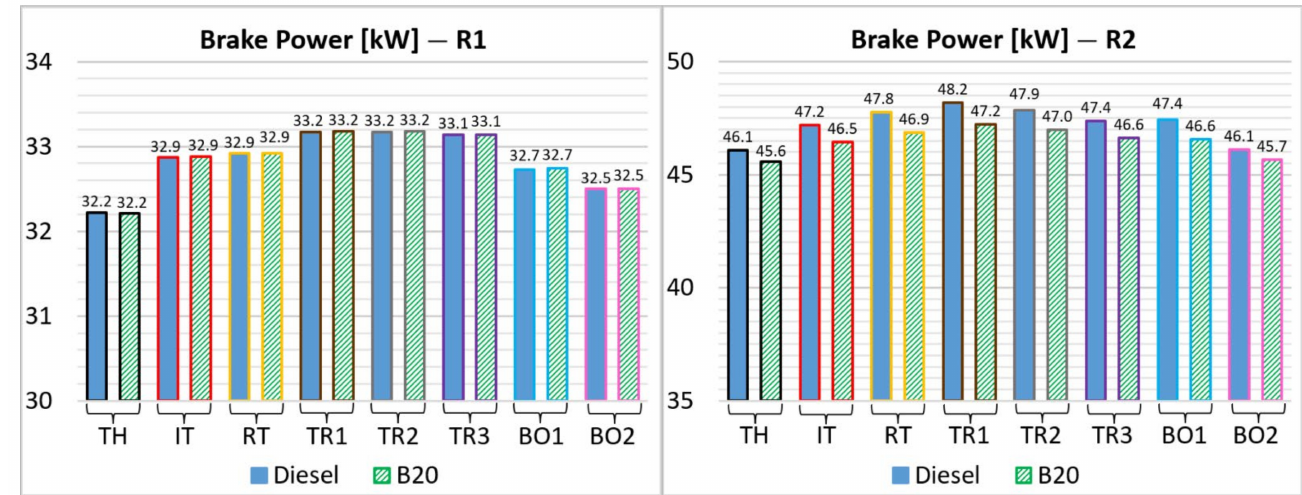
Figure 11. Brake power variation by different shapes of ROI.